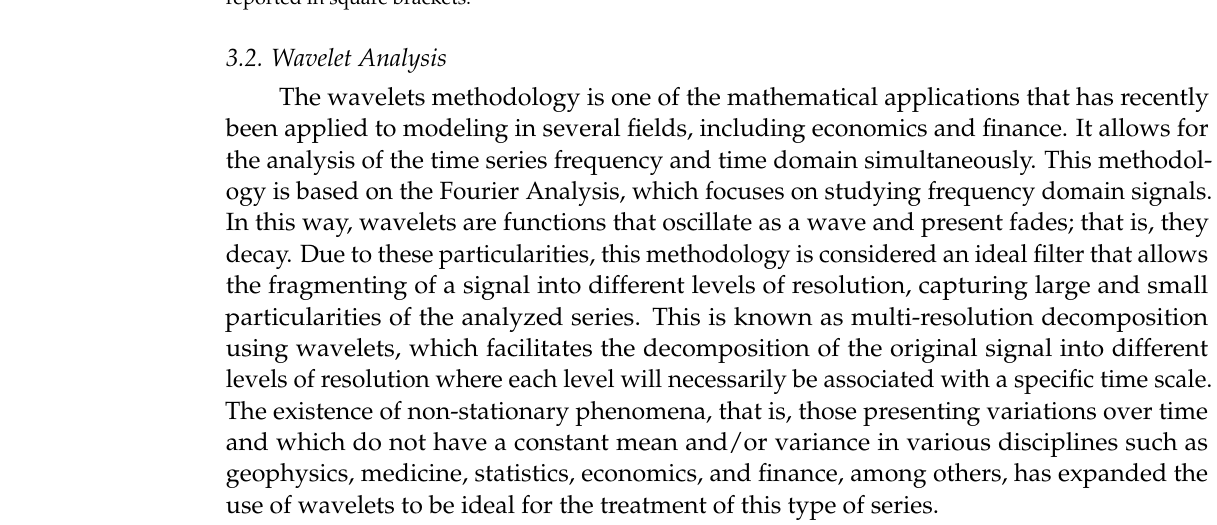
Table 2. Summary statistics of daily returns.